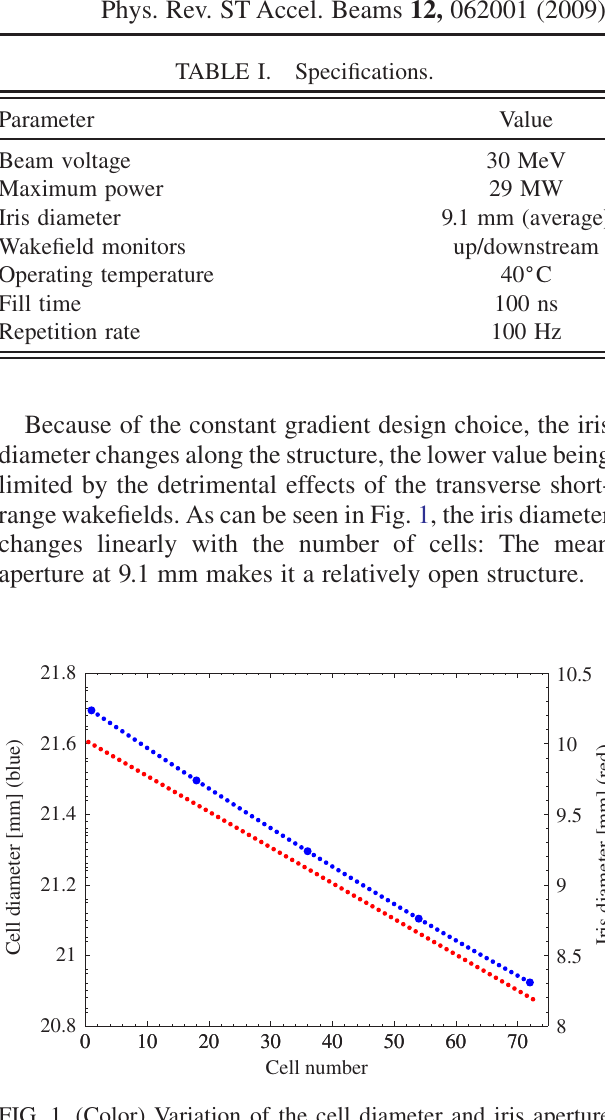
FIG. 1. (Color) Variation of the cell diameter and iris aperture along the structure omitting the monitor cells described later. The first cell has 9.986 mm iris diameter, the last one 8.239 mm.